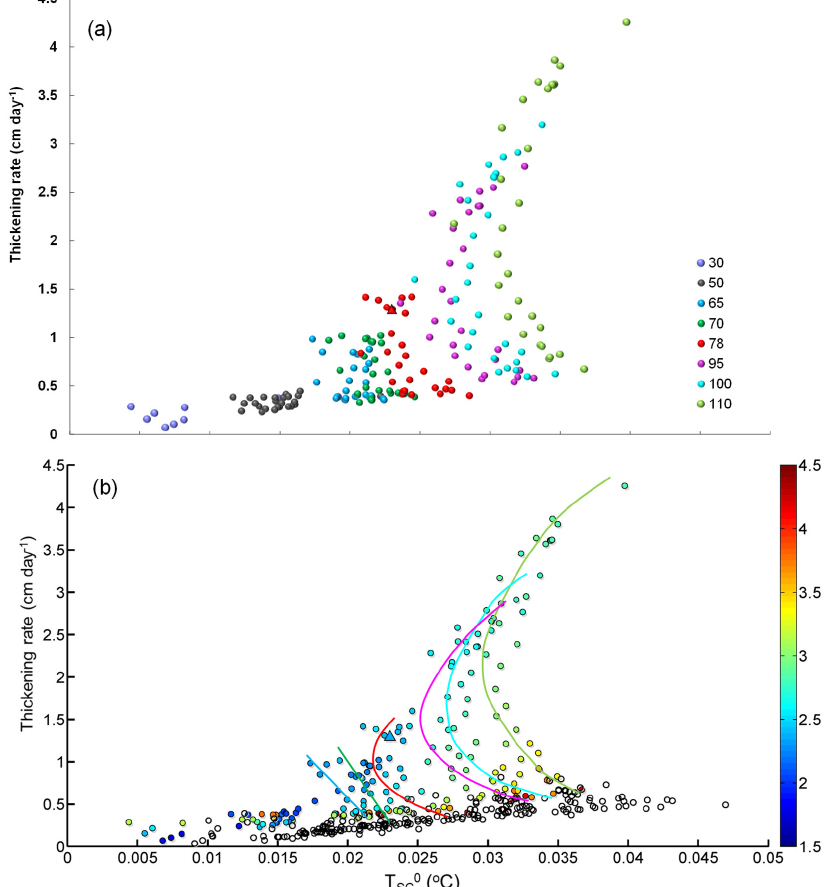
Figure 7. Relationship between T 0 and thickening rate classified by (a) outflow supercooled layer thickness D ini and (b) Z ∗ (colour-coded). SC SC Numbers in the legend of panel (a) represent the values of D ini . Solid and hollow dots in panel (b) correspond to the VM and VU model SC runs, respectively. Coloured lines depict the central trend of the corresponding data points shown in panel (a) . The triangle corresponds to the standard run. The results are from the last 30 days of the model runs.